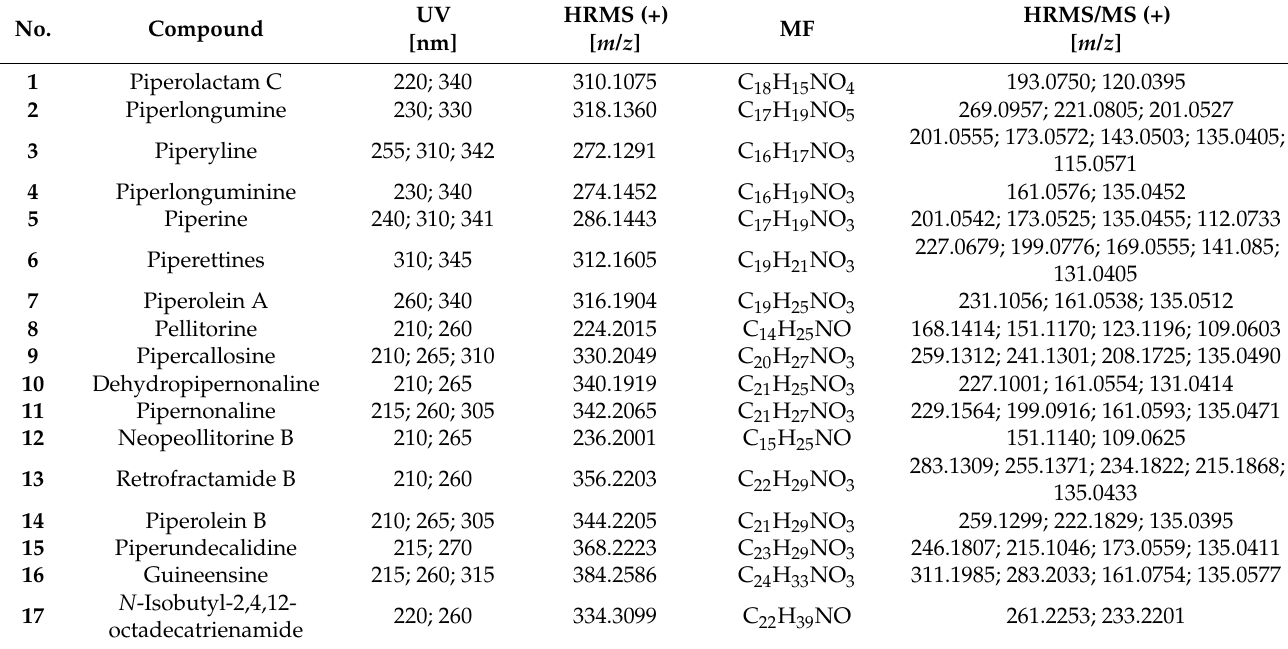
Table 2. LC-HRMS/MS data of piperamides tentatively identified the methanolic fruit extracts obtained from different spices of genus Piper